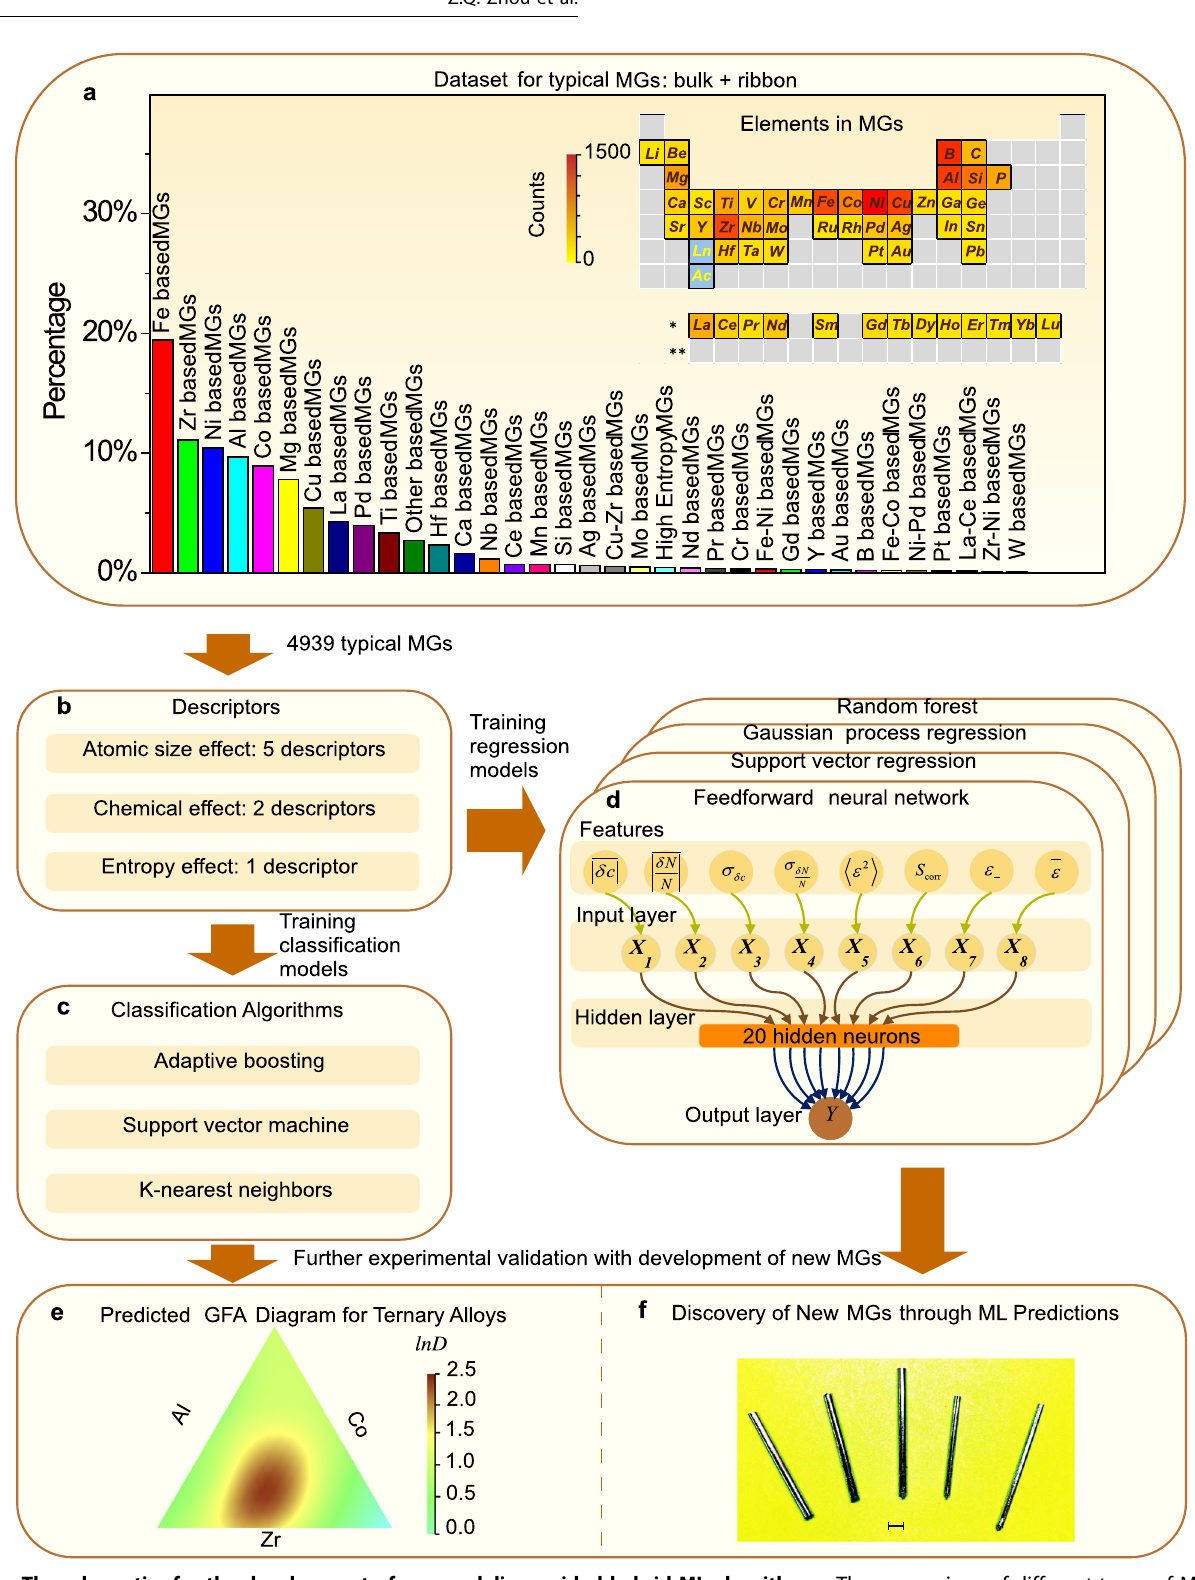
Fig. 1 The schematics for the development of our modeling-guided hybrid ML algorithm. a The comparison of different types of MGs in terms of their proportion in the hitherto reported MGs with measured GFAs. The inset highlights the elements used in the prior development of MGs with counts indicating the total number of times of an individual element being found in the reported MG compositions. b The breakdown of the data descriptors we developed. c The illustration for the training/validation of our classi fi cation ML model based on adaptive boosting (AB), support vector machine (SVM), and k-nearest neighbor (KNN). d The illustrated four types of regression ML models. e The illustration of the predicted GFA diagrams for ternary alloys. f The development of MGs through ML predictions. The scale bar indicates a length of 5